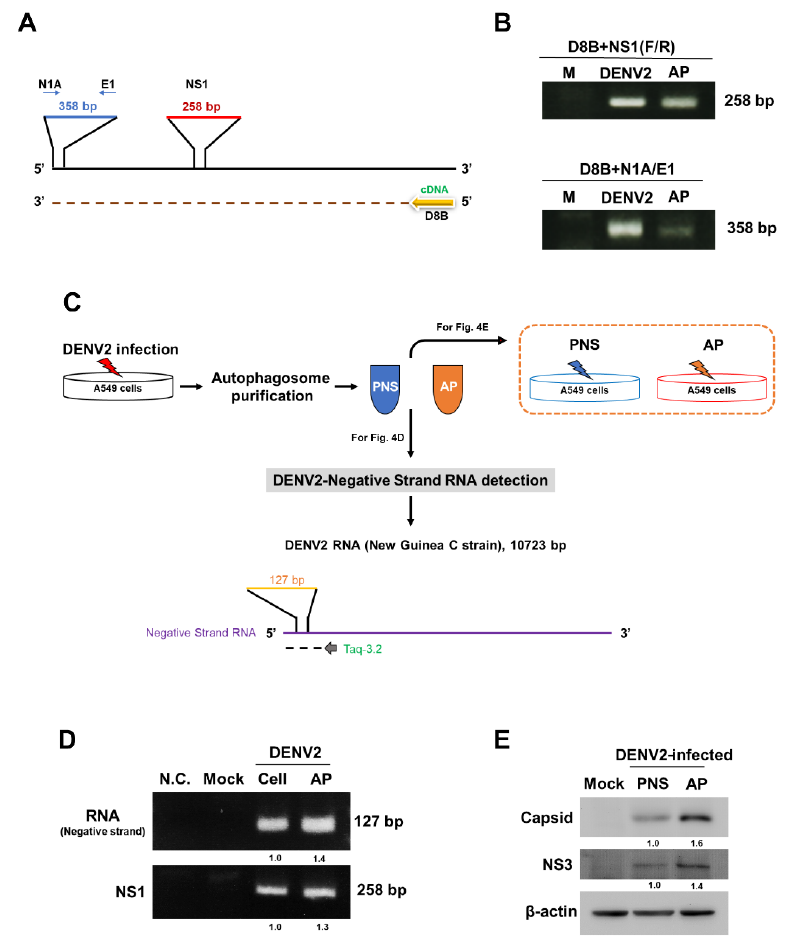
Figure 4. DENV2 RNAs are identified in the purified autophagosomes, which are infectious. ( A ) Primer D8B at the 3′ end of the DENV genome was used for the initiation of cDNA synthesis. The PCR primers N1A-E1 and NS1 were used for PCR amplification and the corresponding fragments and sizes were 258 and 358 bps, respectively. ( B ) RNA was extracted from A549 cells with (DENV) or without DENV2 infection (Mock) and purified autophagosomes from infected cells (AP). The expression of the 5′ end N1A-E1 (358 bp) and middle NS1 (258 bp) region of the DENV2 genome was measured by RT-PCR. ( C ) The experimental design for ( D , E ). The autophagosome was purified from DENV2-infected A549 cells. The upper panel shows the purified autophagosome and PNS were treated with other uninfected A549 cells. The lower panel shows the primer region in the DENV2 genome for cDNA synthesis and PCR of negative-strand DENV2 RNA. ( D ) RNA was ex- tracted from A549 cells with DENV2 (Cell) or without DENV2 infection (Mock) and purified au- tophagosomes from infected cells (AP). The expression of negative-strand RNA and NS1 of DENV2 was determined by RT-PCR. N.C.: control of RT-PCR (without cDNA template). ( E ) A549 cells were cultured with purified autophagosome (AP) or PNS fraction for 72 h, followed by measuring the levels of DENV2 capsid and NS3 proteins by immunoblotting using specific antibodies. N.C.: con- trol of RT-PCR (without cDNA template). The data shows Mean ± SD and the p values were deter- mined by Student’s t -test analysis. 3.5. DENV2 Triggers HMGB1 Exocytosis Partially through Unconventional Secretory Autophagy